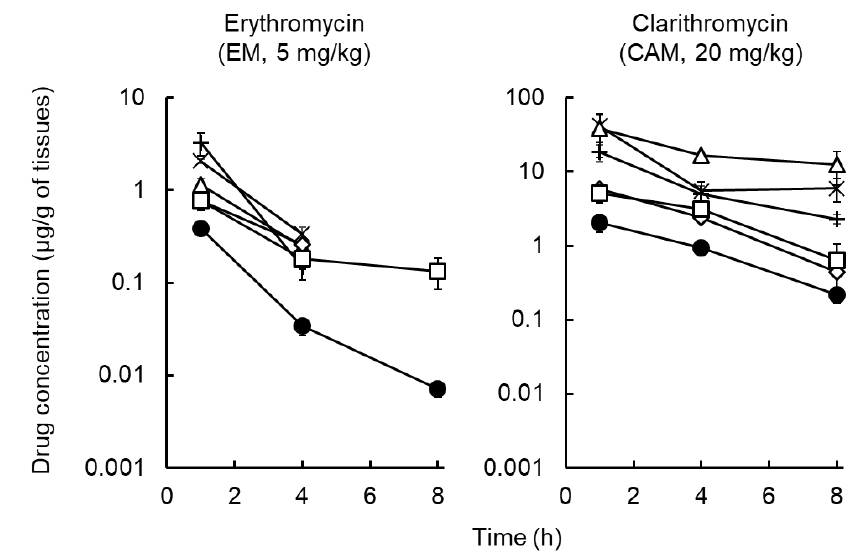
Figure 2. Concentration profiles of erythromycin (EM) and clarithromycin (CAM) in the plasma, liver, kidneys, lung, muscle, and skin after intravenous administration of EM (5 mg/kg) or CAM (20 mg/kg) to rats. (●) plasma; (+) liver; (×) kidneys; ( △ ) lung; (◊) muscle; (□) skin. Each symbol with a bar represents the mean ± S.D. for four to six rats. The EM concentration in the lung, liver, kidney, and muscle at 8 h after administration of EM included 1 or more data of not detected.